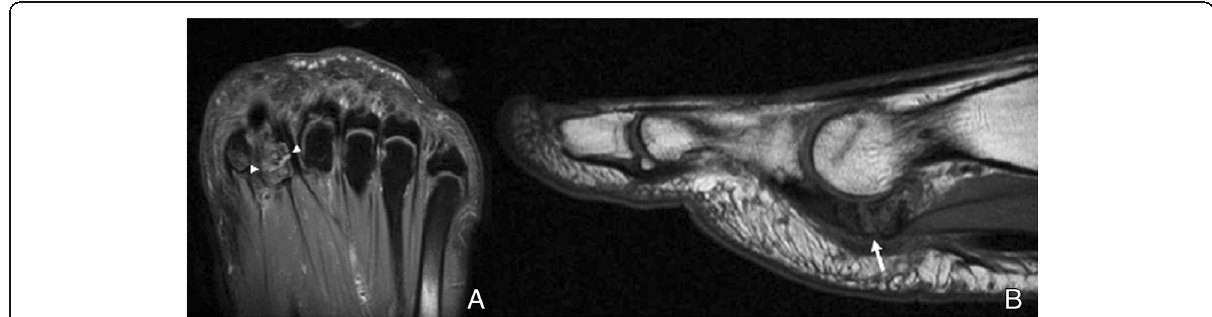
Fig. 13 Lateral sesamoid fracture. A 35-year-old man with pain over plantar aspect of foot after trauma. a Axial FSE PD fat sat demonstrates a fracture of the lateral sesamoid, with slight separation of fragments, and a band of interposed fluid (white arrowheads). b Sagittal FSE T1 demonstrates hypointensity in the fracture fragments. The fracture line is visible, slightly more hyperintense than the adjacent fragments (white arrow)